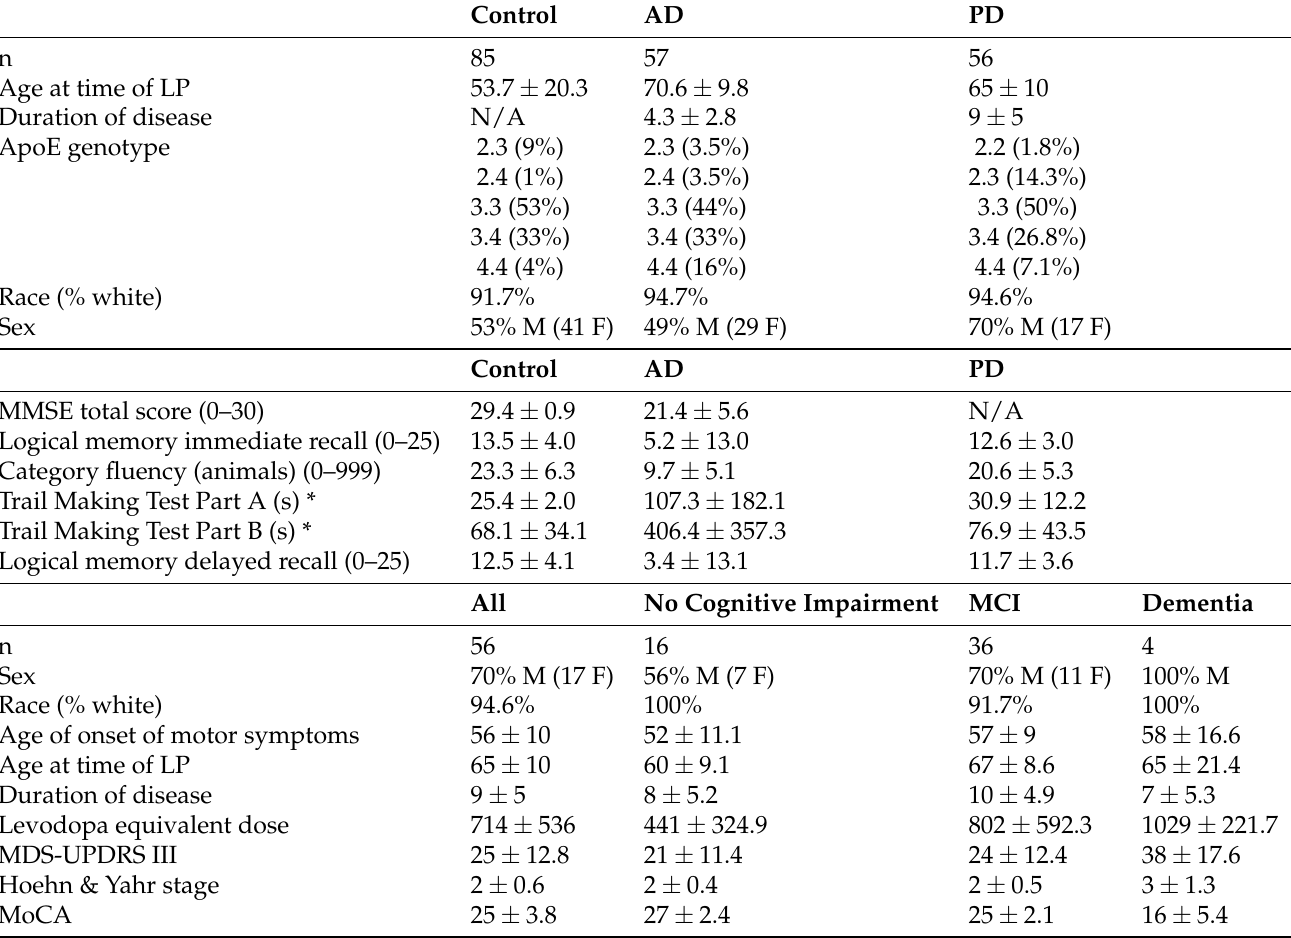
Table 1. Summary of subject data split by phenotype (top), with cognitive test results (middle), and with additional PD subject information (bottom). The cognitive status for PD was classified at three levels: no cognitive impairment, mild cognitive impairment (MCI), and dementia. Age of onset refers to the age of onset of motor symptoms. GBA refers to the carrier frequency for pathogenic GBA mutations and the E326K polymorphism. A chi-squared test of independence for sex and phenotype reports a p -value of 0.051. A one-way ANOVA of age at time of LP and phenotype reports a p -value of 2.099 × 10 − 9